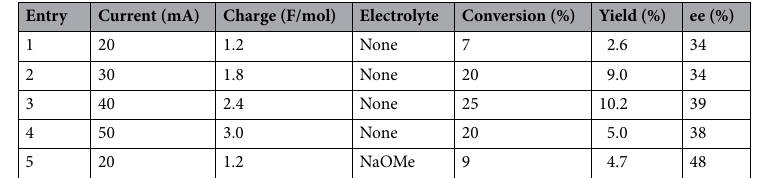
Table 1. Continuous flow elecrochemical screening of current/ charge results with platinum as the cathode and graphite as the anode. Constant parameters: electrodes (Pt cathode/C anode), Temperature (rt), flow rate (0.05 ml/min) and concentration (0.05 M). General procedure: a solution of 1-([1, 1 ′ -biphenyl]-2-carbonyl) pyrrolidine-2-carboxylic acid 1 in MeOH was formed and was injected in the microreactor. The current and the flow rate were fixed. ee value were evaluated by chiral HPLC analysis. Isolated yield: purification by TLC preparative (silica gel, n -hexane/EtOAc 1:2).